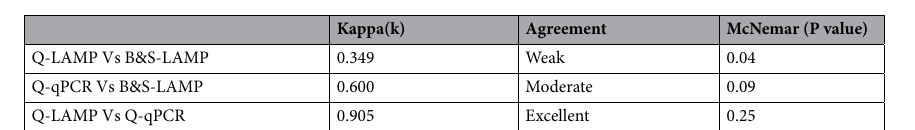
Table 3. Agreement between the assays while DNA isolated through a commercial kit and an in-house boil & spin method.